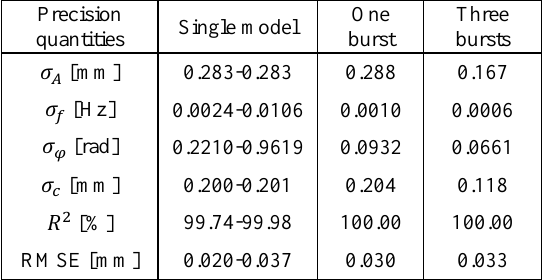
Table 1. Statistical values for the sinusoidal fitting parameters estimated for 𝑍 (1 Hz)